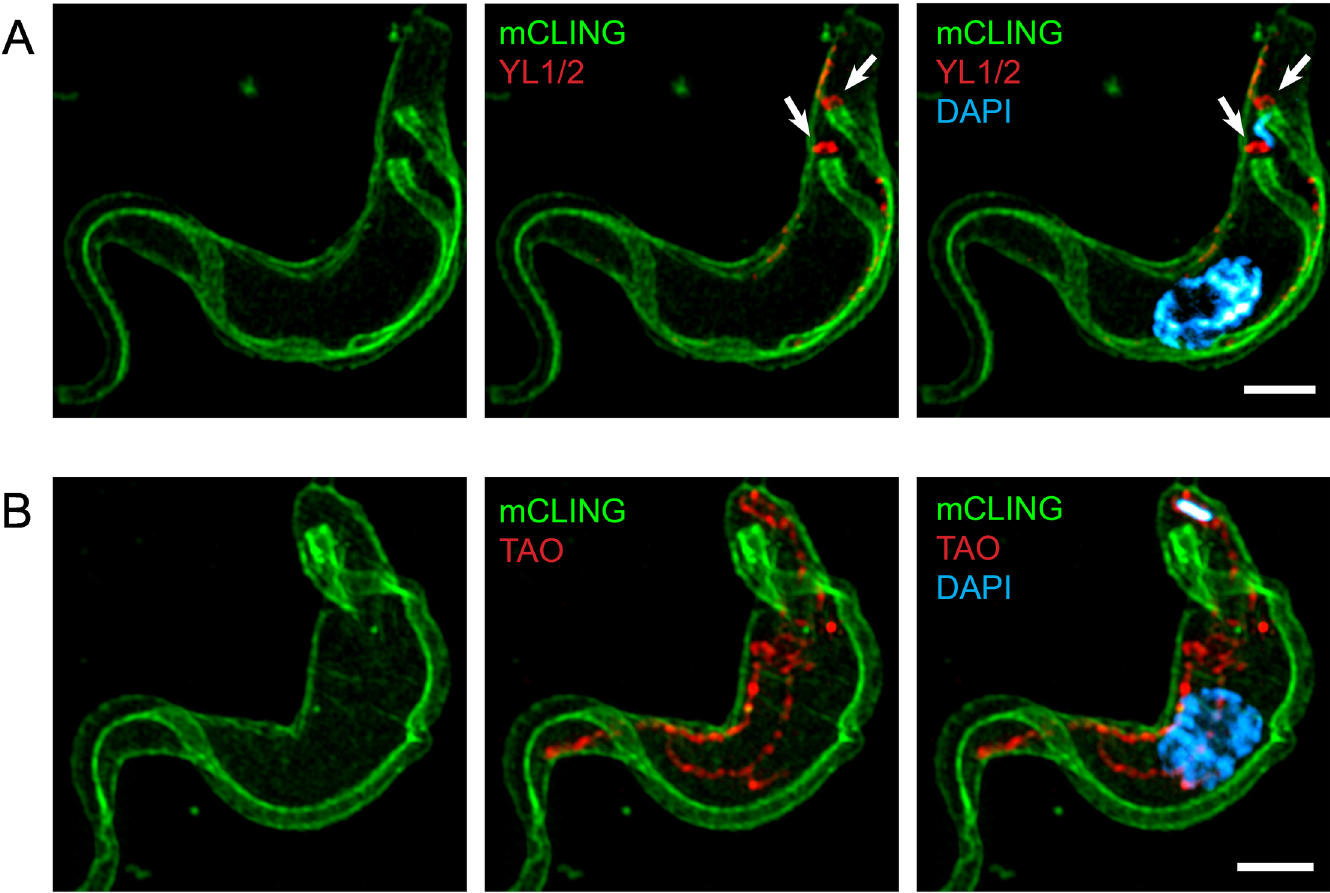
Fig 2. Double-labeling of trypanosomes with antibodies and mCLING. Trypanosomes were incubated with mCLING-488 on ice, then fixed and subjected to “antigen retrieval” before incubation with primary and fluorescent secondary antibodies. The kinetoplast and nucleus were stained with DAPI. Panels presented are maximum intensity projections of 3D SR-SIM images. (A): The trypanosome basal body protein TbRP2 was labeled with YL1/2 primary antibody and AlexaFluor-594 secondary antibody. (B): Trypanosome mitochondrial alternative oxidase (TAO) was labeled with anti-TAO primary antibody and AlexaFluor-594 secondary antibody. Scale bar = 2